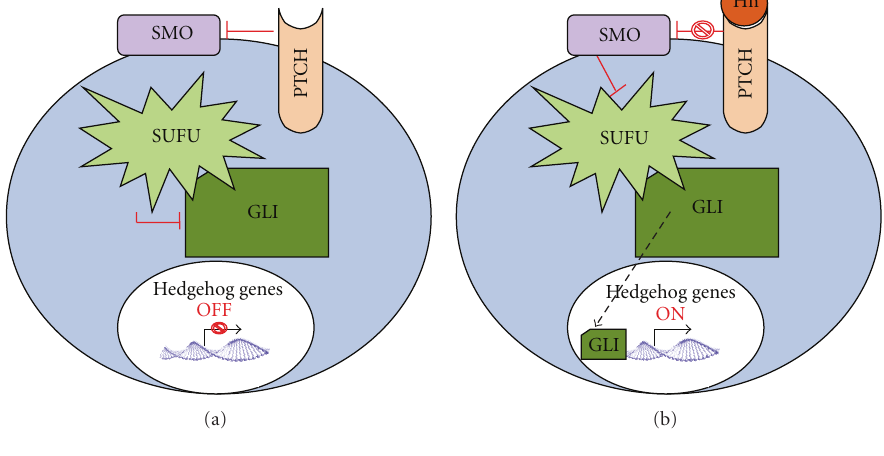
Figure 1: The Hedgehog pathway